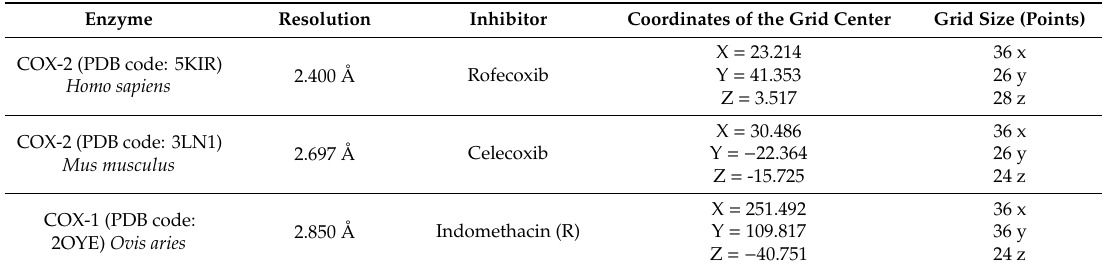
Table 16. Protocol data used in the validation of molecular